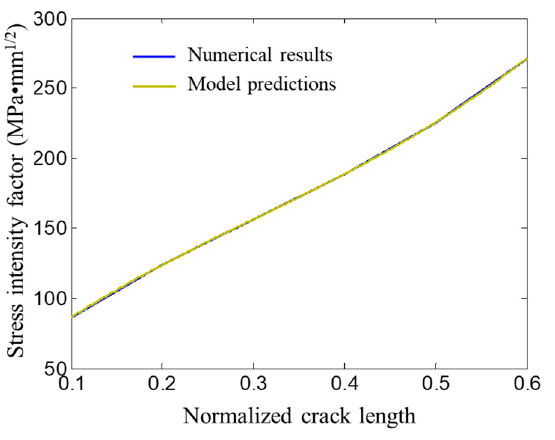
Figure 14. Comparison between numerical results and model predictions under load of 300 MPa.